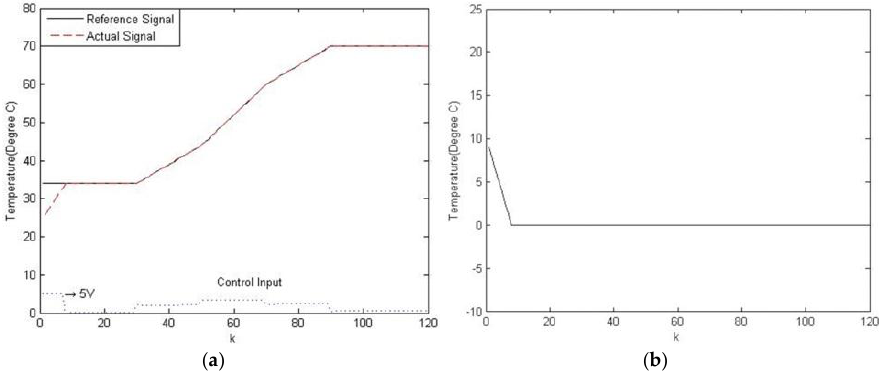
Figure 28. ( a ) Tracking outputs and ( b ) errors of the FNFN controller when a change occurs in the water bath system.